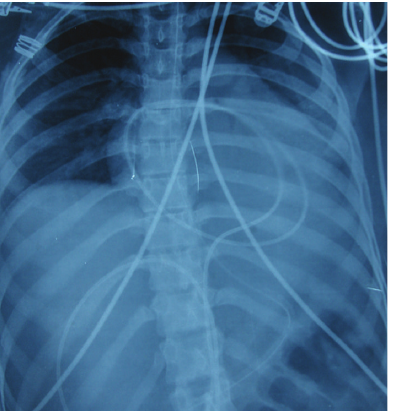
Figure 5: Repeat CXR film showing no increase in pleural or pericardial